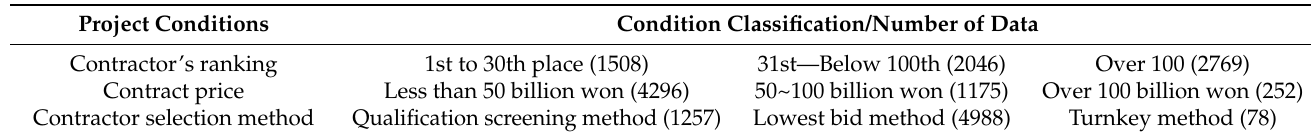
Table 5. Classification criteria for deriving rules for design change by project condition. Project Conditions Condition Classification/Number of